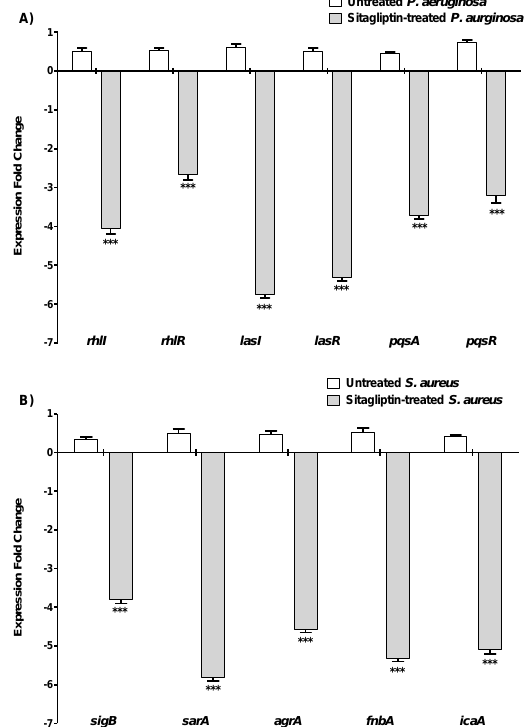
Figure 4. Downregulation of QS- and biofilm-formation-encoding genes in P. aeruginosa and S. aureus . RNA was collected from P. aeruginosa or S. aureus samples that were treated or not with sitagliptin at sub-MIC, and the expression levels of genes were normalized to housekeeping genes rpoD or 16s rRNA , respectively. The experiment was repeated in triplicate, and the data are expressed as mean ± SD. One-way ANOVA test, followed by Dunnett’s multiple comparison test, was employed to test significance. Sitagliptin significantly downregulated the expression of ( A ) QS-encoding genes in P. aeruginosa and ( B ) QS- and biofilm-formation-encoding genes in S. aureus. ***: p ≤